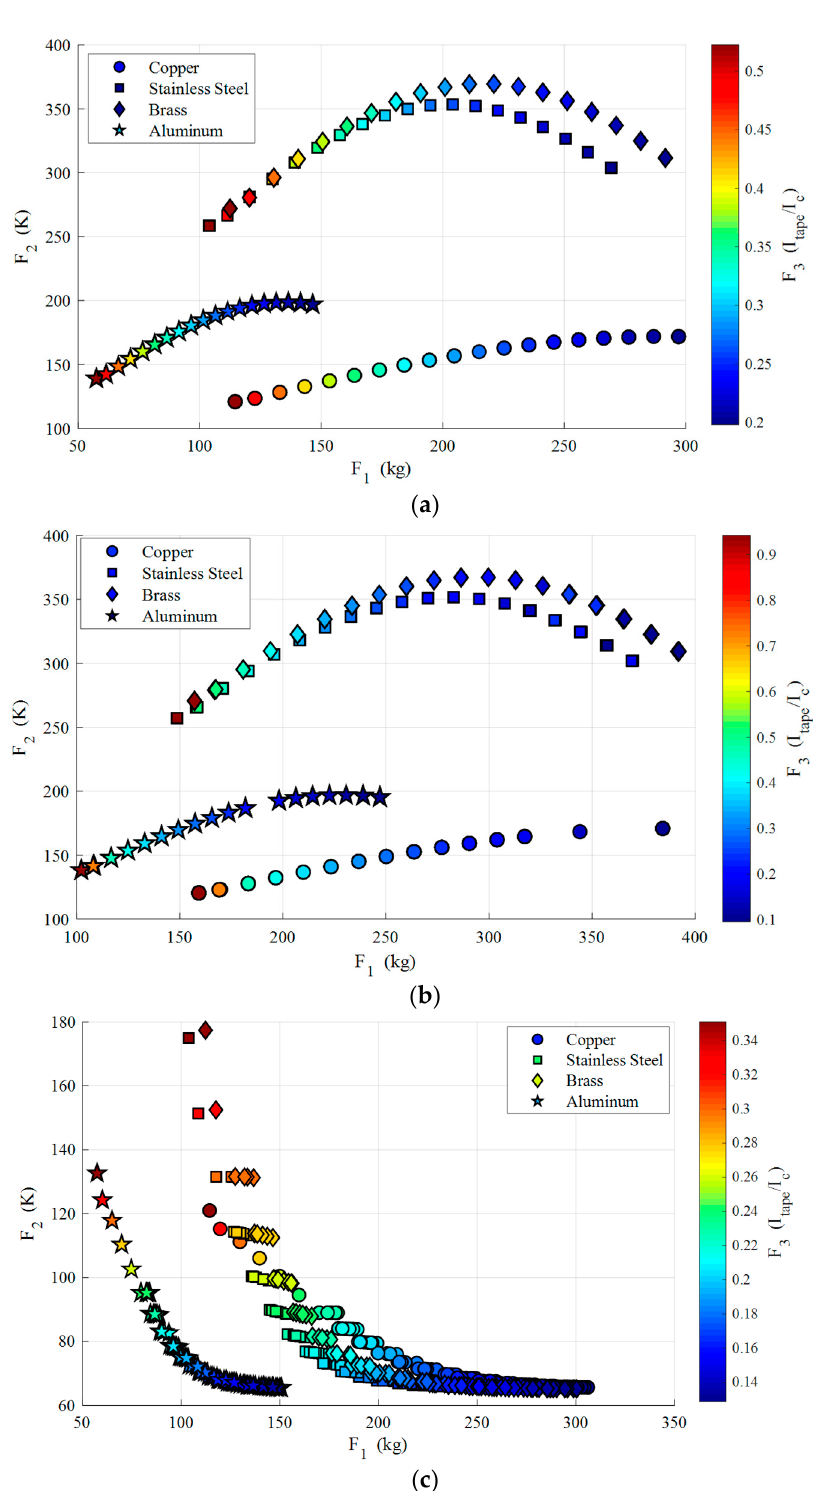
Figure 6 . Pareto front of NSGA II optimization for different former materials of understudied DC HTS cables: ( a ) cable A, ( b ) cable B, ( c ) cable C .